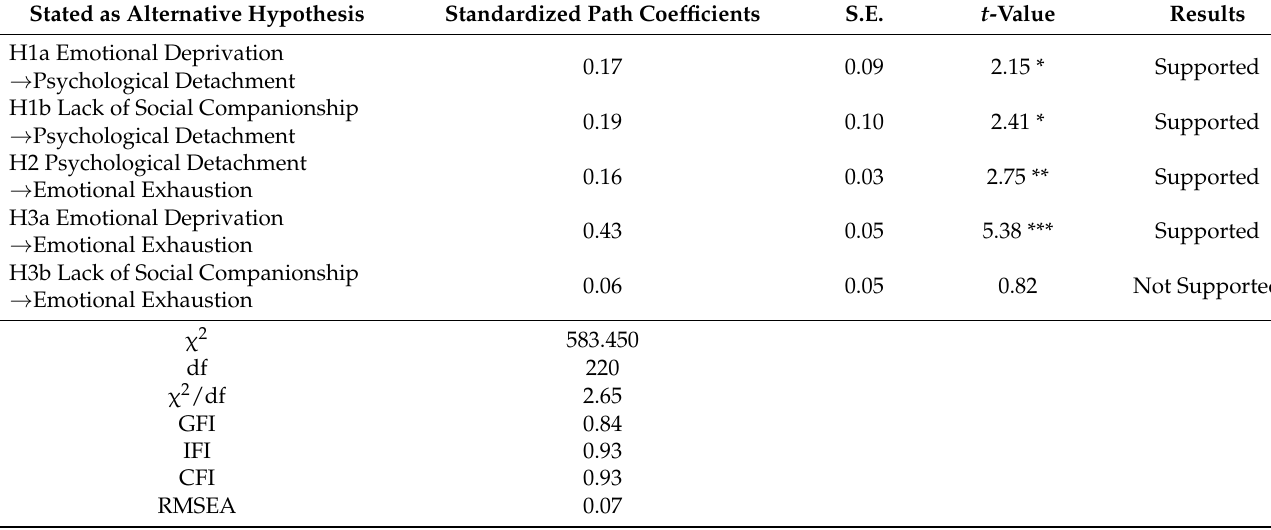
Table 4. Structural parameter